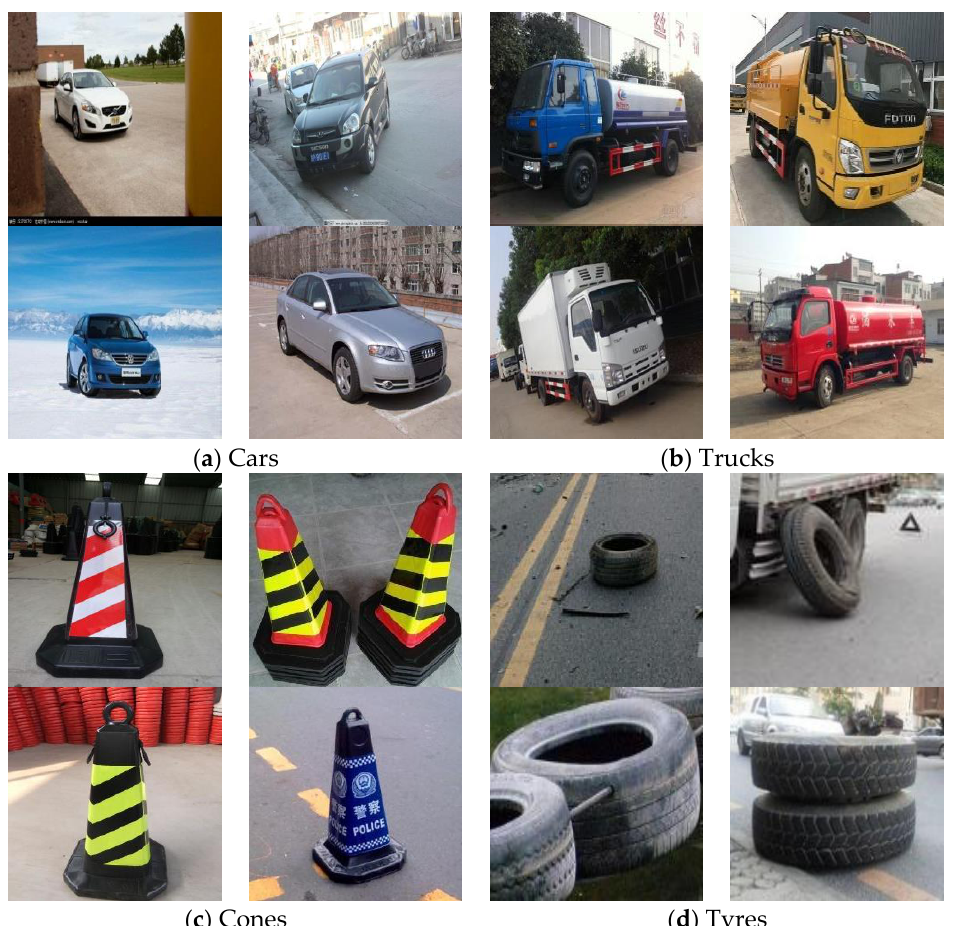
Figure 6. Several categories of training samples ( a ) cars ( b ) trucks ( c ) cones ( d ) tyres. 11 cars, 10 trucks, 10 cones, and 8 tyres are selected as the incomplete training samples. 199 cars, 225 trucks, 210 cones, and 112 tyres. 72 images were selected as unlabeled data.